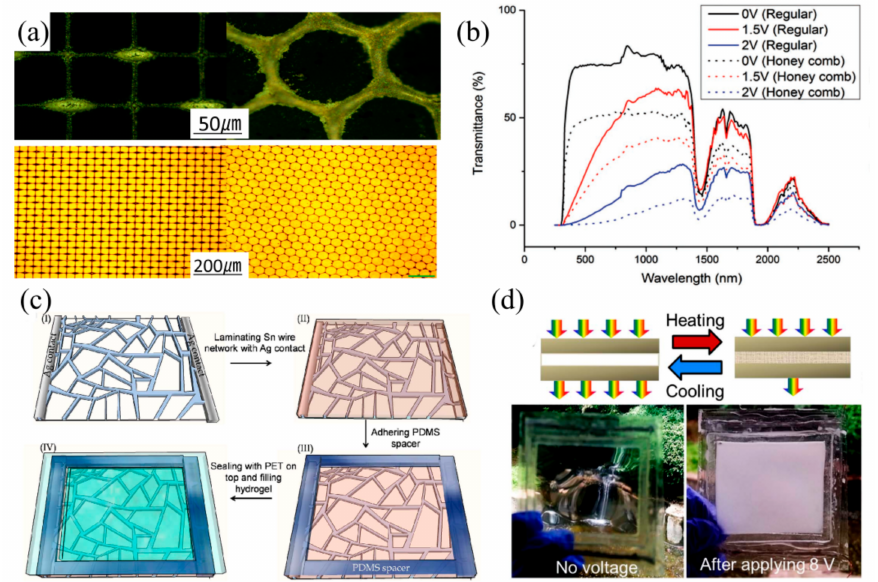
Figure 6. ( a ) Ag mesh electrode square and honeycomb arrays. Reproduced with permission from [52]. Copyright 2016, Wiley. ( b ) Sunlight transmittance of conventional and honeycomb arrays [52]. ( c ) Schematic diagram of the manufacturing steps of Sn/hydrogel devices. Reproduced with permission from [53]. Copyright 2017, Elsevier. ( d ) Cu/HPMC hydrogel before and after Joule heating [53]. Reproduced with permission from [53]. Copyright 2017, Royal Society of